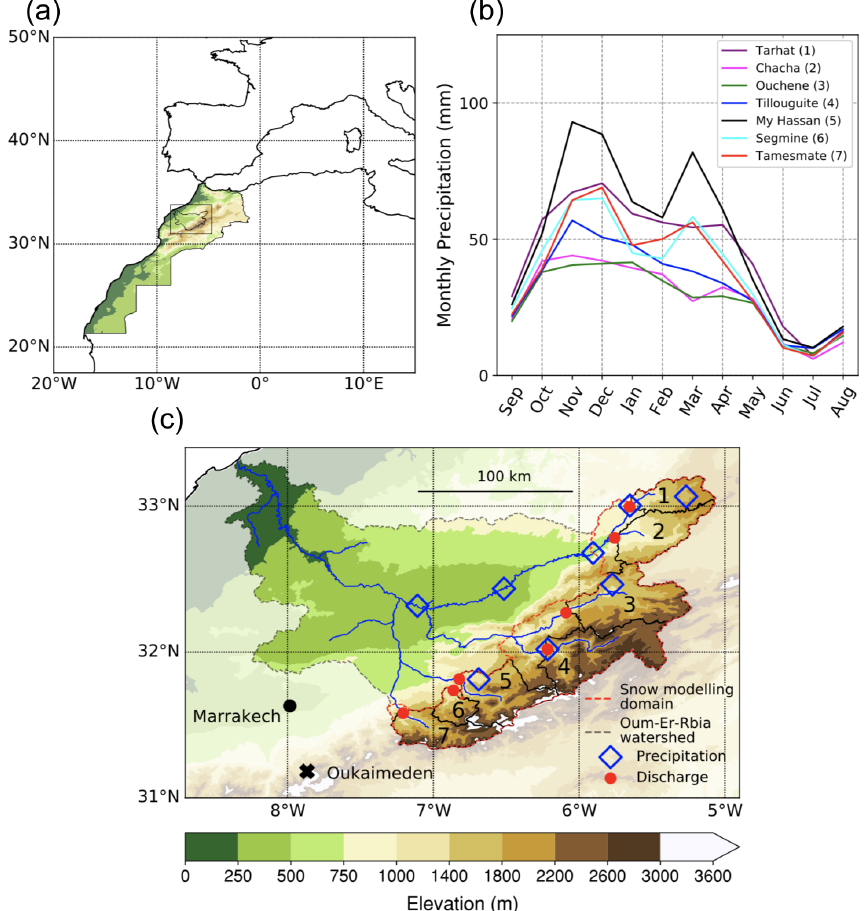
Figure 1. (a) Location of our study area within Morocco (shading: elevation; see colour bar in c ). (b) Annual cycles of precipitation for the seven catchments, based on TRMM data (1998–2015). (c) Map of the Oum-Er-Rbia watershed, with elevation shown by shaded contours. The main waterways are indicated by solid blue lines. Blue diamonds and red circles indicate the location of precipitation and river discharge stations, respectively. The snow modelling domain is shown by the dashed red line. The seven catchments defined by the discharge stations are shown by solid black lines and are indicated by numbers: (1) Tarhat, (2) Chacha, (3) Ouchene, (4) Tillouguite, (5) Moulay Hassan, (6) Segmine and (7) Tamesmate. The location of the Oukaimeden snow station, outside our study area, is shown by a black